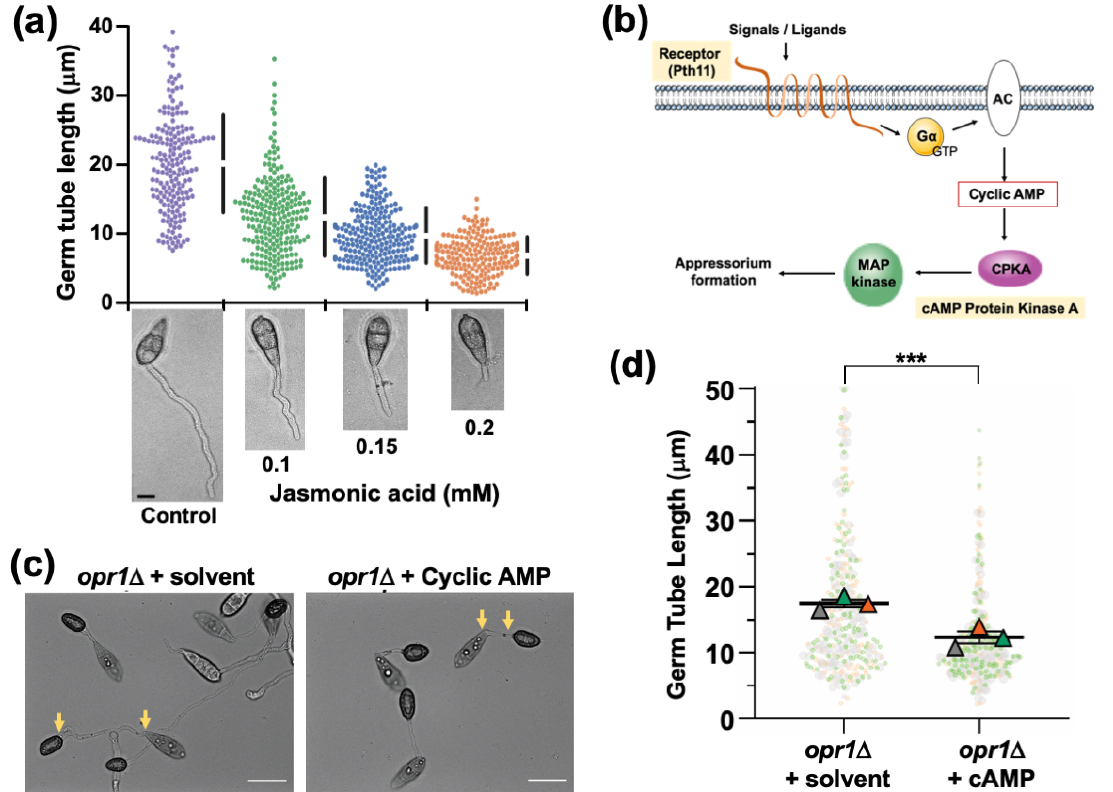
Figure 5. JA regulates germ tube development and appressorium formation in concert with the cyclic AMP signaling in Magnaporthe. ( a ) Exogenous JA shortens the germ tube length/growth on a non-inductive surface. Conidia from the WT strain were inoculated on a non-inductive hydrophilic surface in the presence of the indicated amounts of JA and germ tube growth assessed at 8 hpi. Data represents mean ± SE from three independent repeats of the experiment, each involving at least 300 conidia. Micrographs of the WT germ tubes formed on a non-inductive surface upon treatment with the indicated JA concentration. Scale bar equals 5 μ m. ( b ) Schematic depiction of the heterotrimeric G proteins/cyclic AMP-PKA signalling cascade essential for appressorium formation in the rice blast fungus. Exogenous stimuli activate the membrane-localized GPCR Pth11 to trigger the downstream G proteins. Mac1, an adenylate cyclase, catalyses the ATP to cAMP conversion. Induced cAMP during pathogenic differentiation activates the CPKA kinase, triggering the downstream signaling, including the Pmk1-MAPK cascade, thus leading to appressorium formation. ( c ) Exogenous cAMP suppresses the dual defects of elongated germ tubes and delayed appressorium formation in the opr1 Δ mutant. Germ tube development and appressorium formation was assessed on the inductive surface in opr1 Δ conidia in the presence or absence of cyclic AMP. Images were captured at 24 hpi. Scale bar = 10 μ m. ( d ) Graphical depiction of the quantitative analysis of the germ tube length in conidia, capable of appressorium formation in opr1 Δ . Dots represent length measurement of each germ tube in three independent replicates of the experiment with n = 300 conidia in each instance. Triangles depict mean ± SE value of the three repeats. *** p < 0.001.